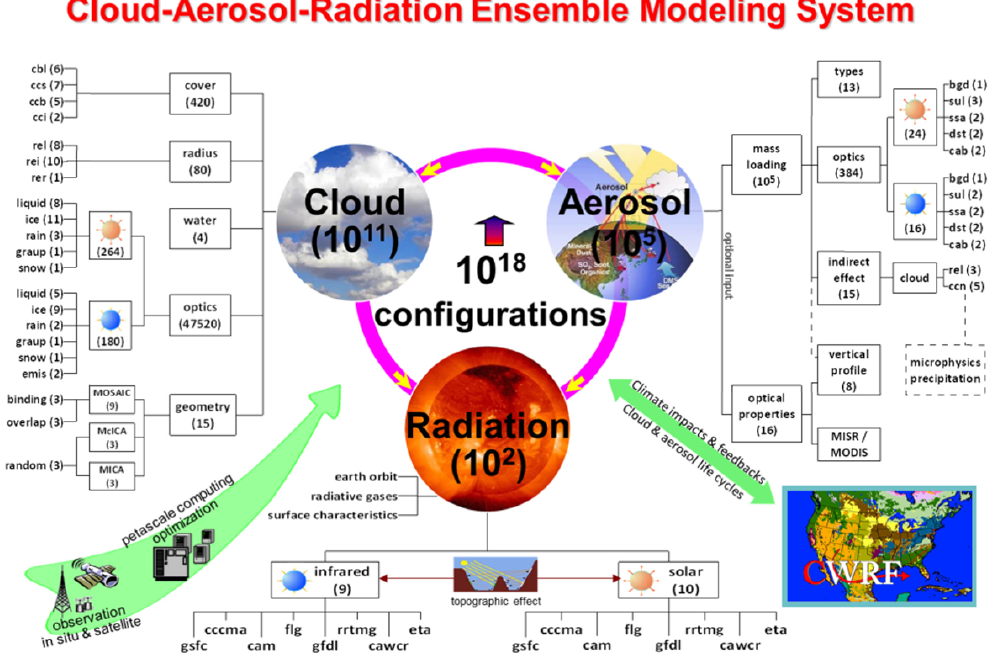
Fig. 1. Schematic of the interactive cloud–aerosol–radiation ensemble model (CAR), illustrating all key groups of parameterizations currently available (each with a number of schemes listed in parentheses) and their links with directional data flow by arrows. Shown also are petascale computing optimization against in situ and satellite observations for ensemble size reduction, as well as the full coupling with CWRF for integration of impacts to and feedbacks from climate variations over the US, where the interactive system evaluation is presented